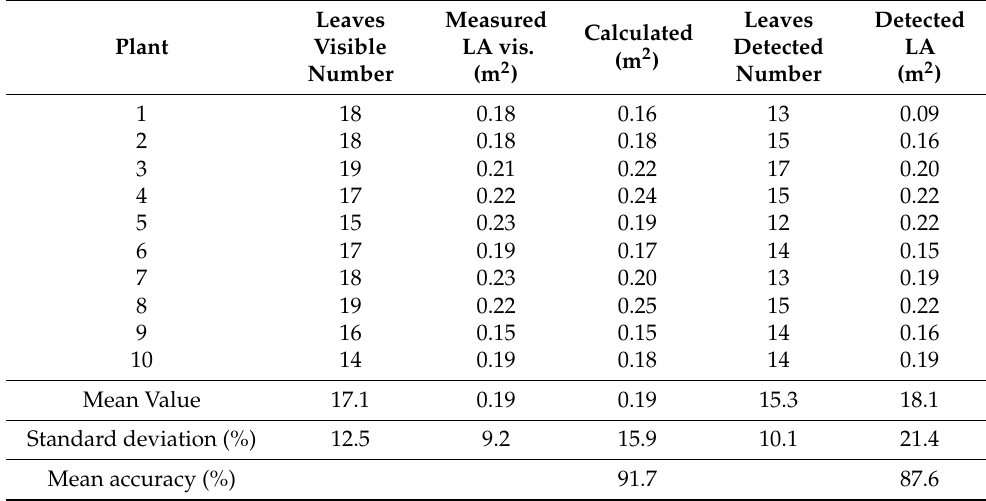
Table 6. BBCH 41: comparison of measured, calculated (calc.), and detected leaf area and the mean accuracy (MA) of the visible leaves (vis.). Plant